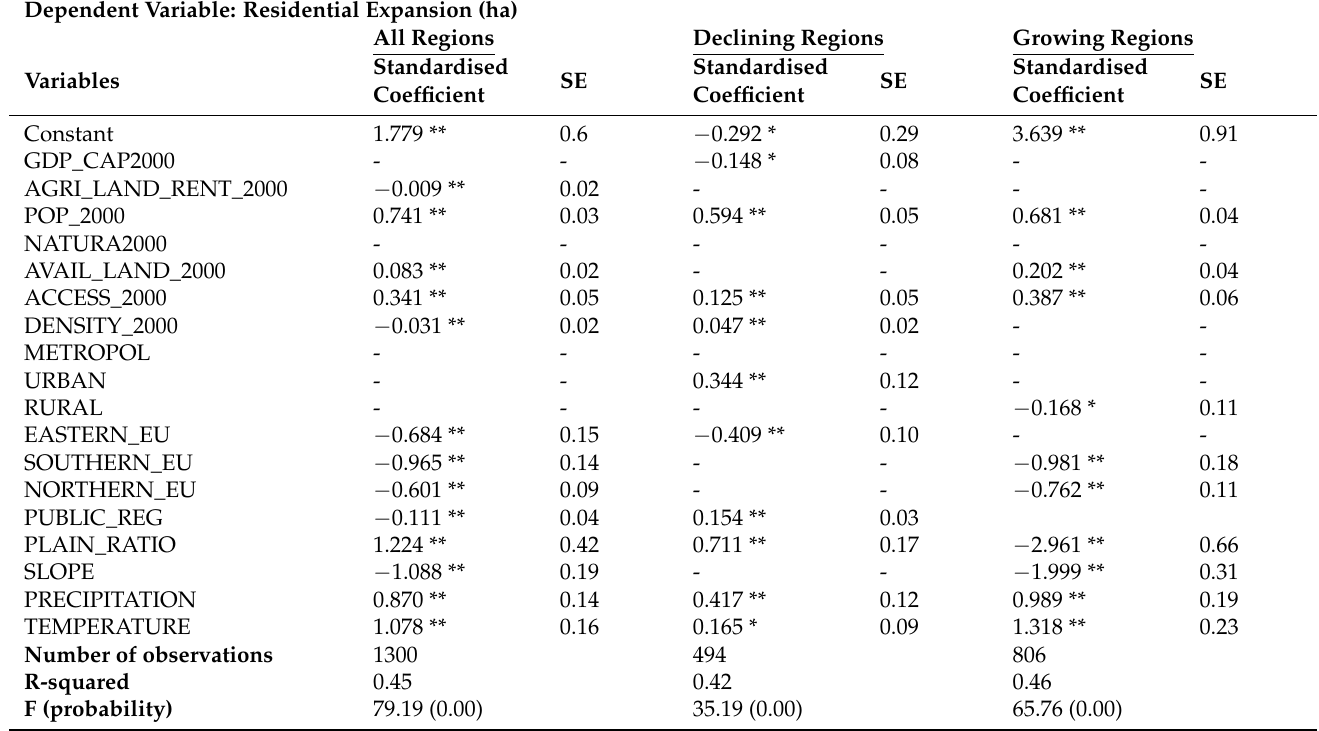
Table 3. Results of the regression analysis explaining residential expansion density in EU